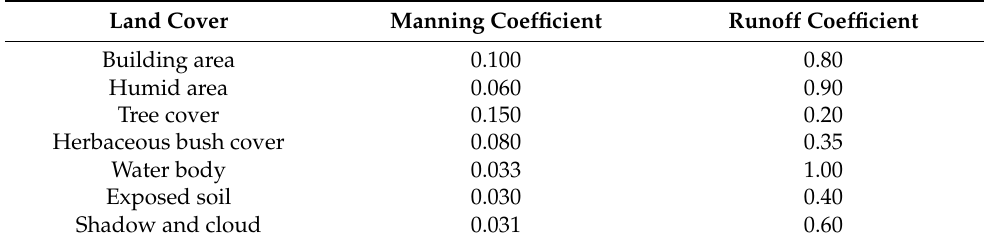
Table 8. Manning and runoff coefficients for the modeled area.